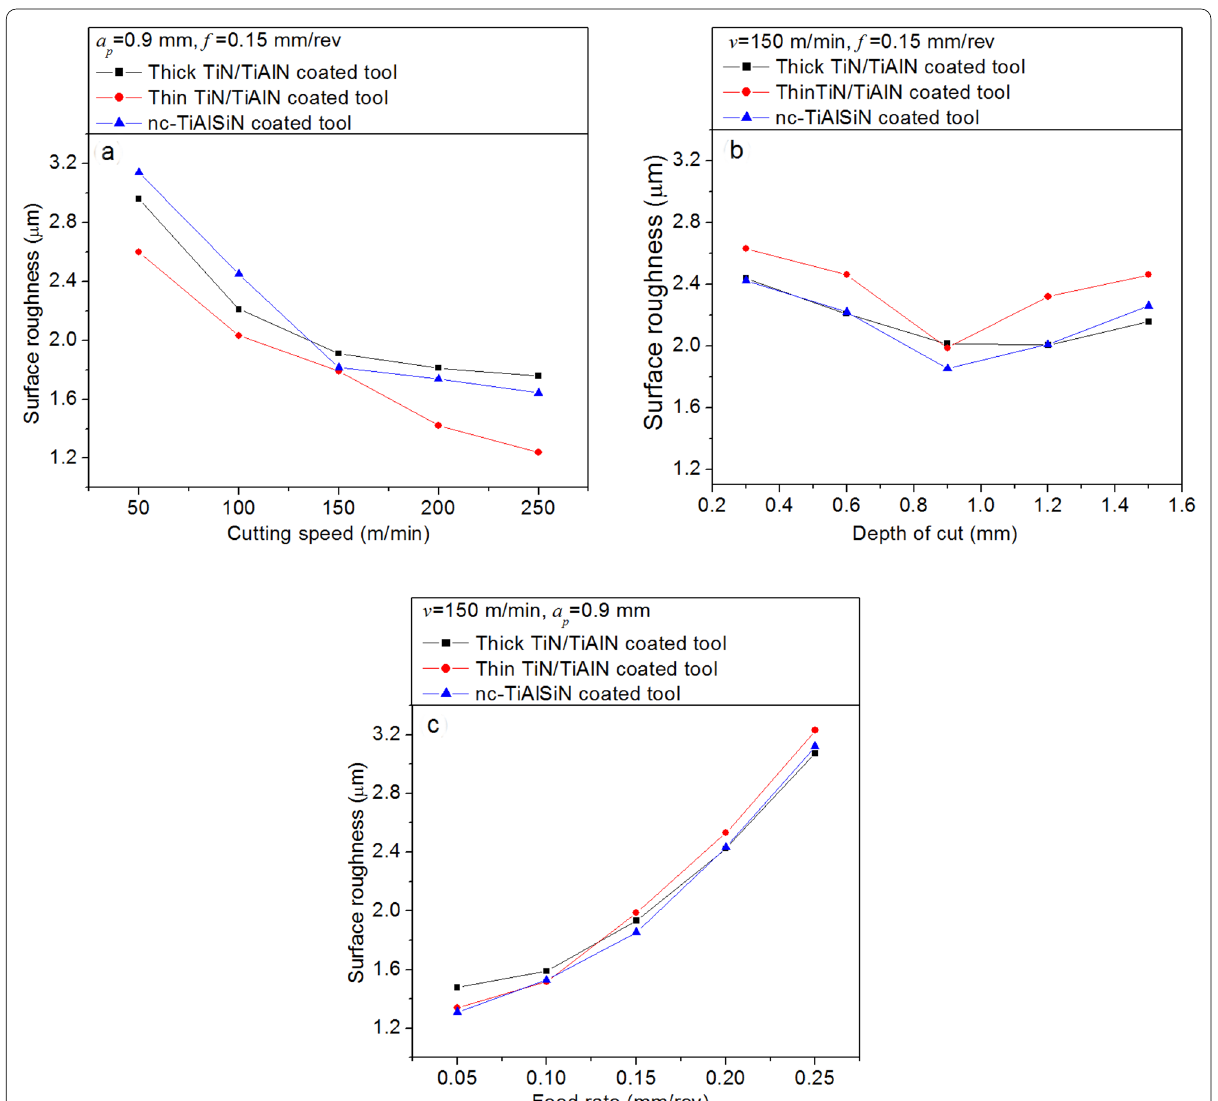
Figure 11 Surface roughness values of the three coated tools under various cutting conditions in dry turning of MCI: a a p rev; b v 150 m/min, a p 0.9 mm and c v = =